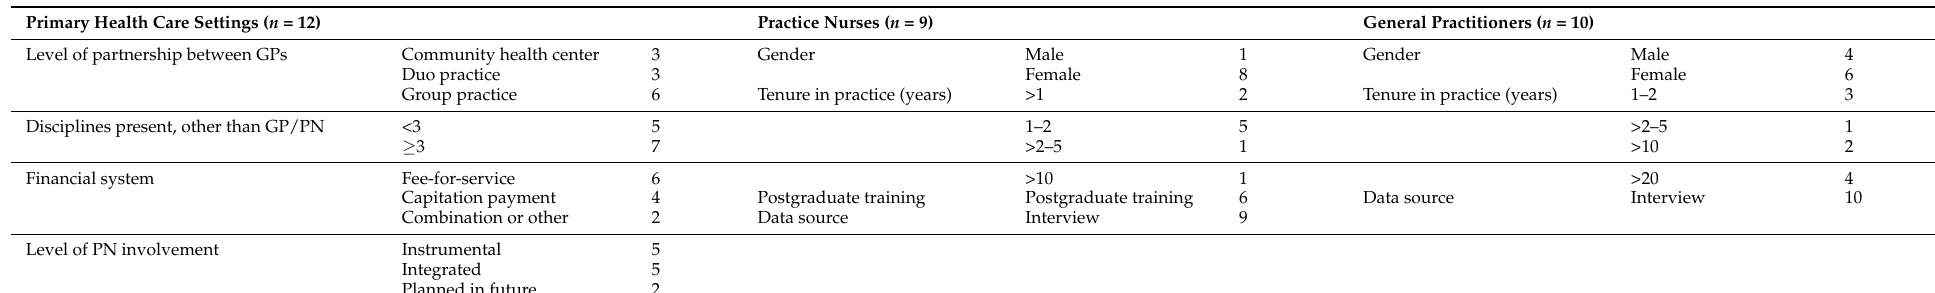
Table 2. Phase 2 primary health care setting, practice nurse, and general practitioner